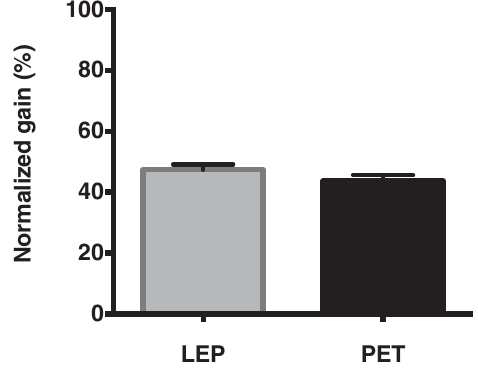
FIG. 7. Content assessment average percentage normalized gain for LEP ( N ¼ 326 ) and PET ( N ¼ 309 ) students ( p ¼ 0 . 15 ; t ¼ 1 . 456 df ¼ 633